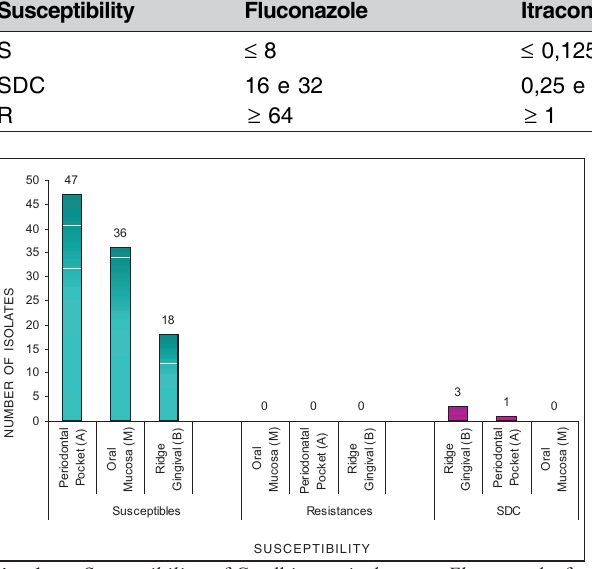
Fig. 1a - Susceptibility of C. albicans isolates to Fluconazole for sites collected.